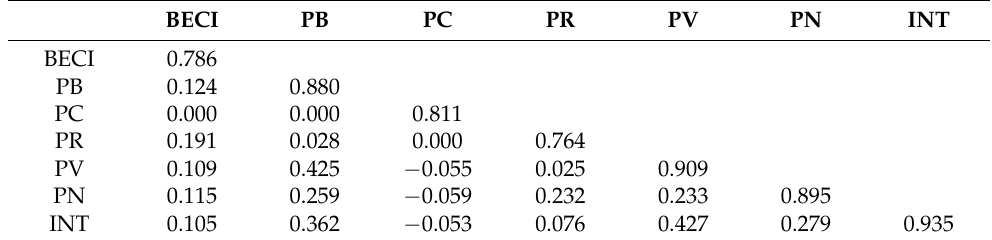
Table 2. Correlation matrix and square roots of the AVEs.